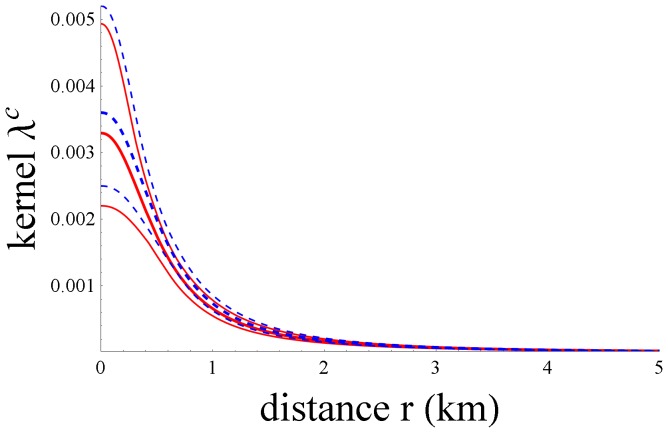
Estimated transmission kernels λc and their confidence bounds.The basic kernel parameterization is given by c = 0 in Equation (1) and (2) without farm-size dependence (dashed blue line) and the best-fit kernel c = 5 (solid red line), where NS is set equal to the average size of the farms in the OA (1038.3) and NI to the average size of the infected farms in the OA (1515.7), with their confidence bounds (thinner lines).